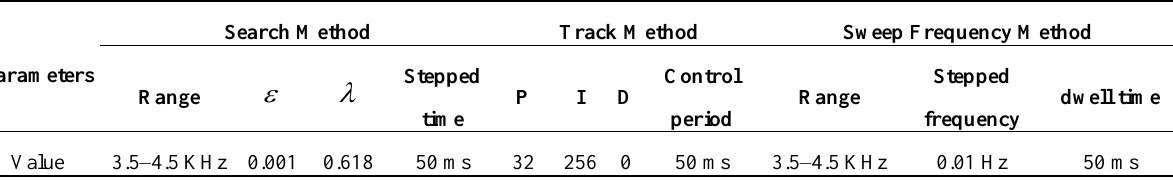
Table 4. Parameters in the experiments.